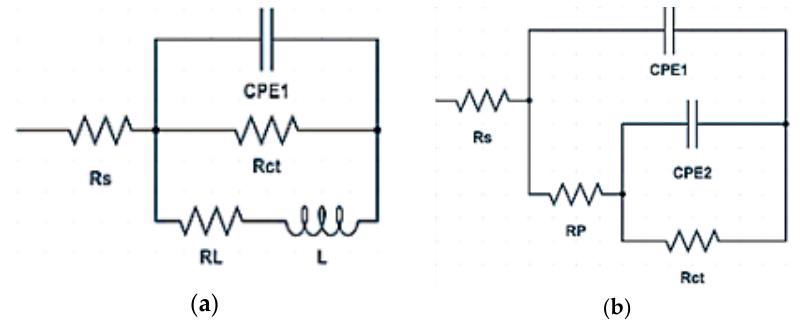
Figure 9. The equivalent circuit models for ( a ) AM60-BM and ( b ) PEO-coated samples . Table 4. EIS fitting results of the studied conditions in 0.5 M NaCl solution.